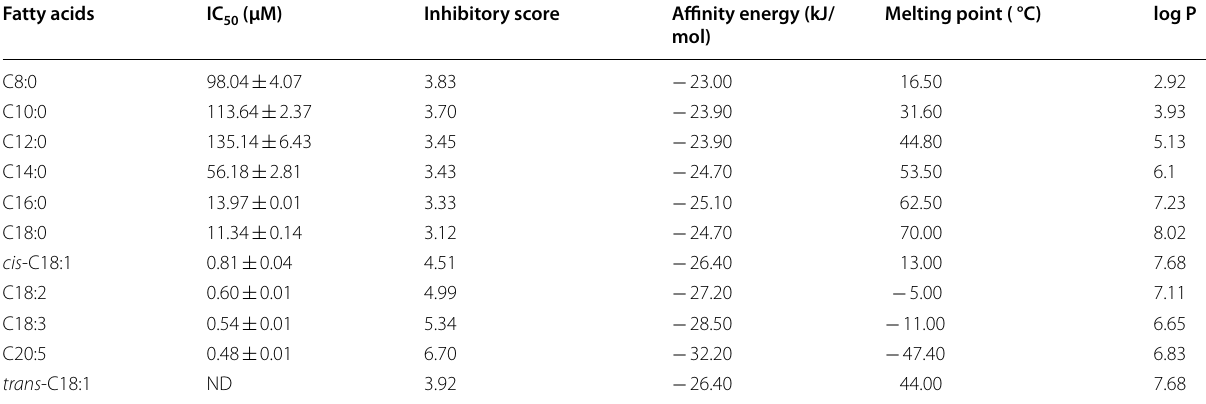
Table 2 The IC , inhibitory score, affinity energy and melting point of various FFA 50 Fatty